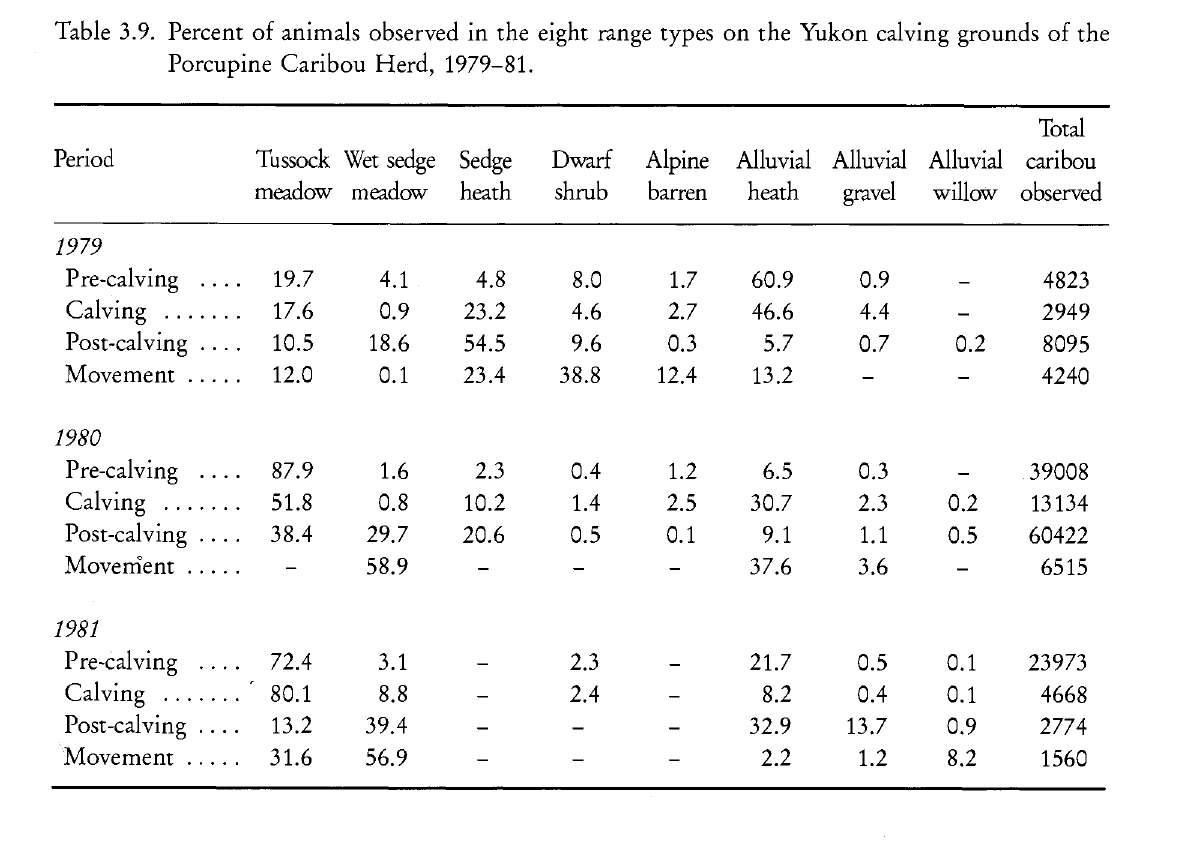
Table 3.9. Percent of animals observed in the eight range types on the Yukon calving grounds of the Porcupine Caribou Herd, 1979-81. Dwarf Alpine Alluvial Alluvial Alluvial caribou